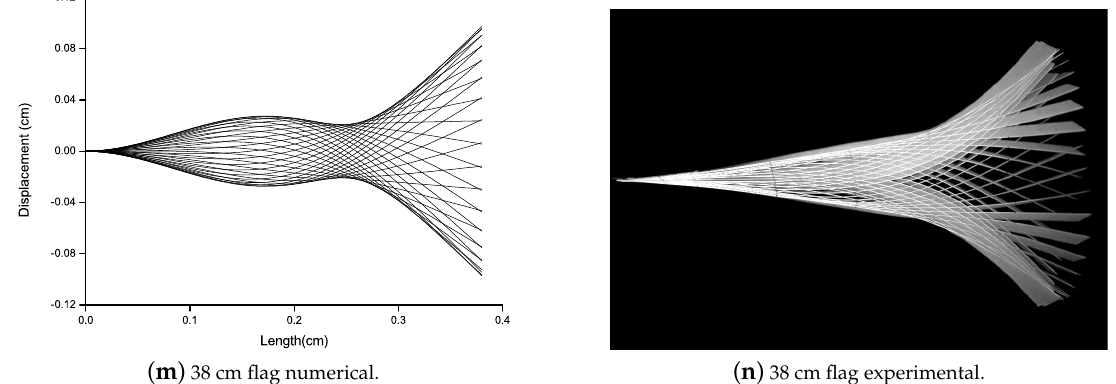
Figure 8. Deformation comparison for Al patched flags varying from 15 cm to 38 cm long flags.